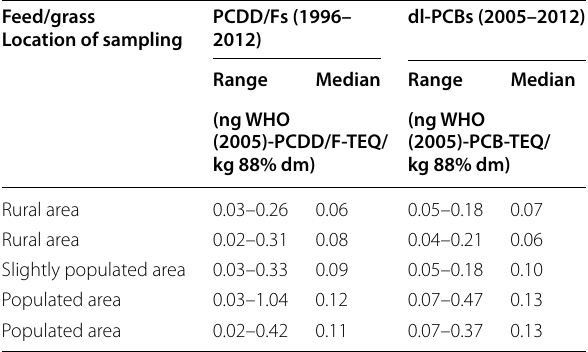
Table 1 Levels of PCDD/Fs and dl-PCBs in feed samples (grass, hay, grass silage), results of the